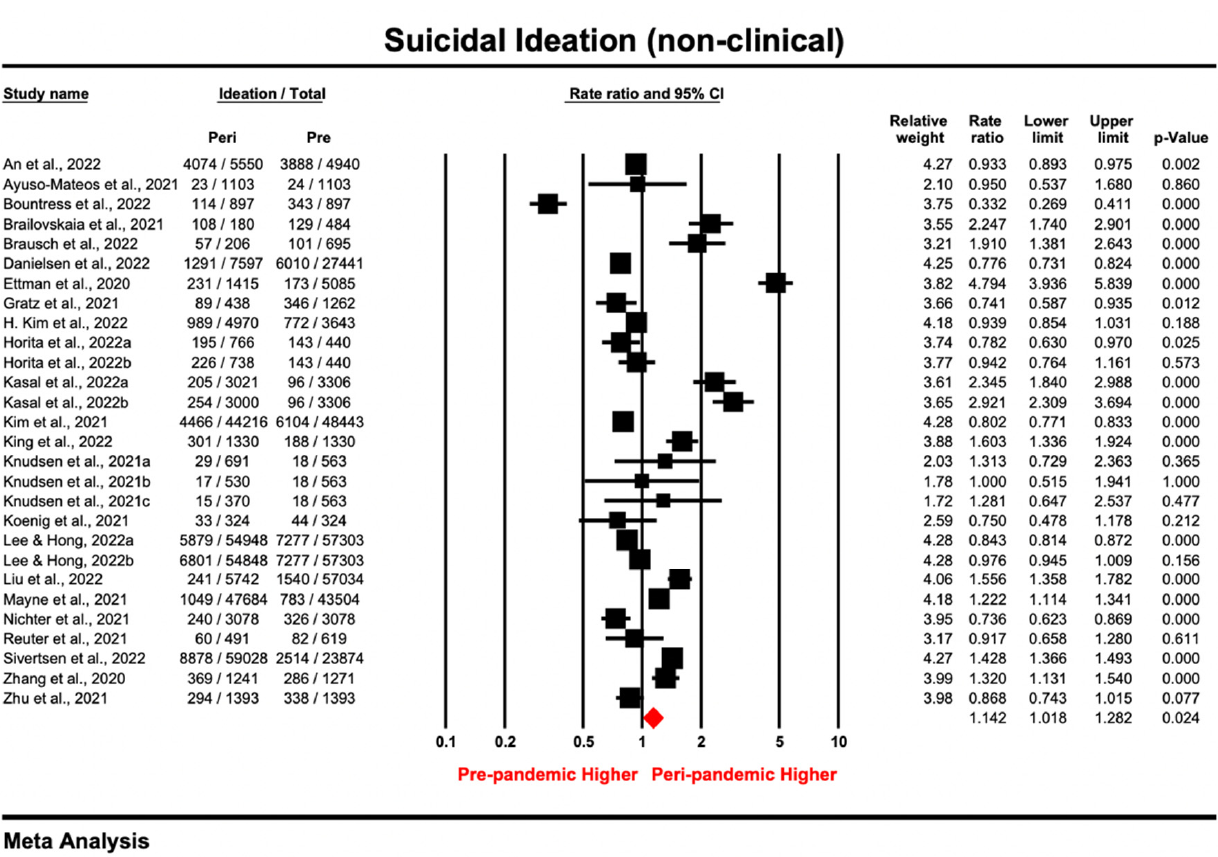
Figure 2. Forest plot for suicidal ideation of studies [9–12,15,51–58,61,64,93,97–100,102,108,112] conducting in the non-clinical setting (Prismatic colored as red refers to the pooled estimate).